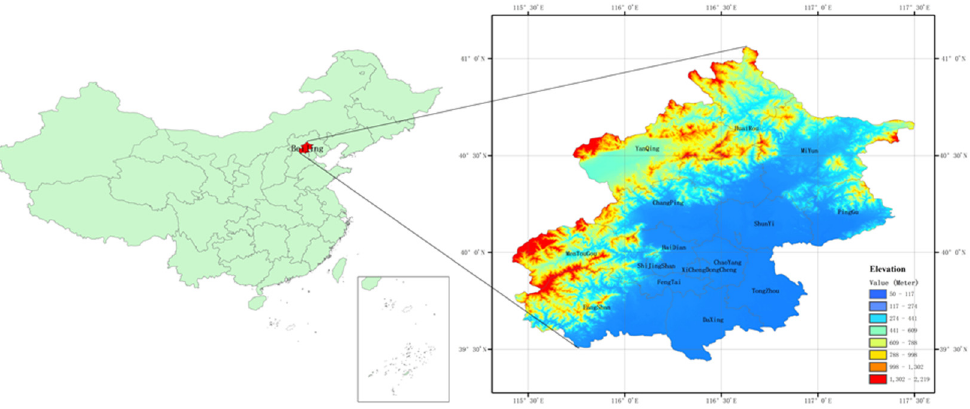
Figure 1. Study area and location of the Beijing region in China.